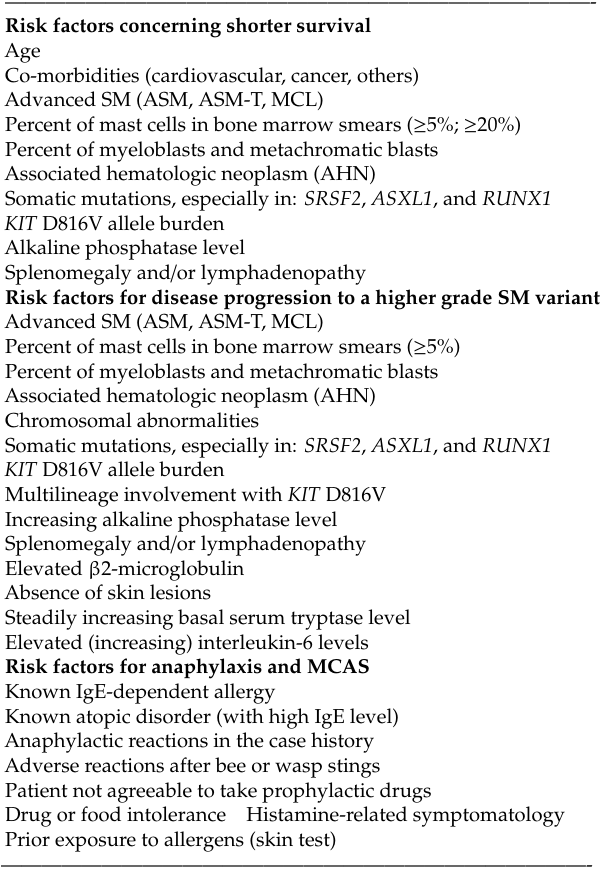
Table 4. Risk factors in patients with systemic mastocytosis